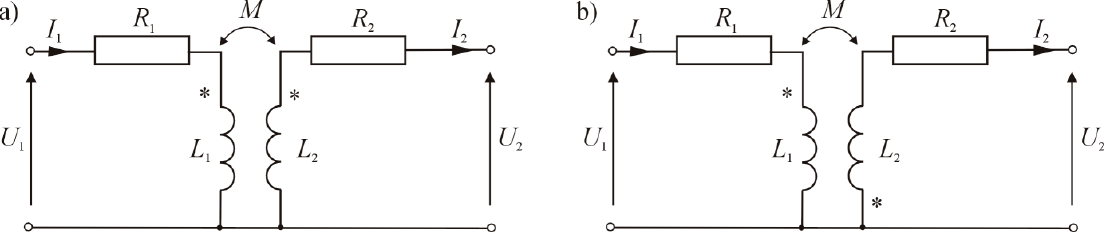
Figure 1. Classical magnetic coupling of two coils: ( a ) opposite; ( b ) matching magnetic polarity. L 1 and L 2 : self-inductance of coils, respectively; M : mutual inductance of coils; R 1 and R 2 : coil resistance, respectively.